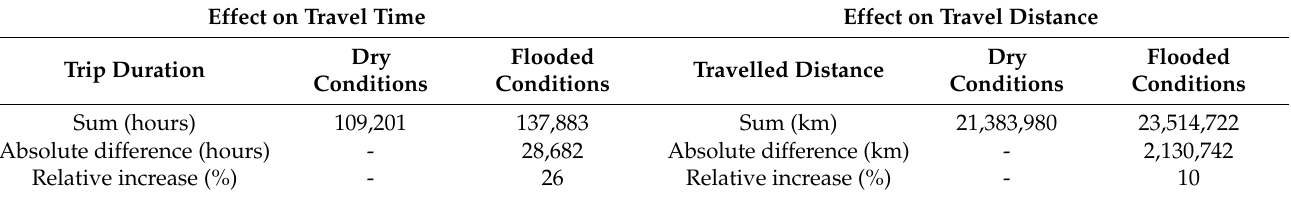
Table 6. Flood effects on travel time and travel